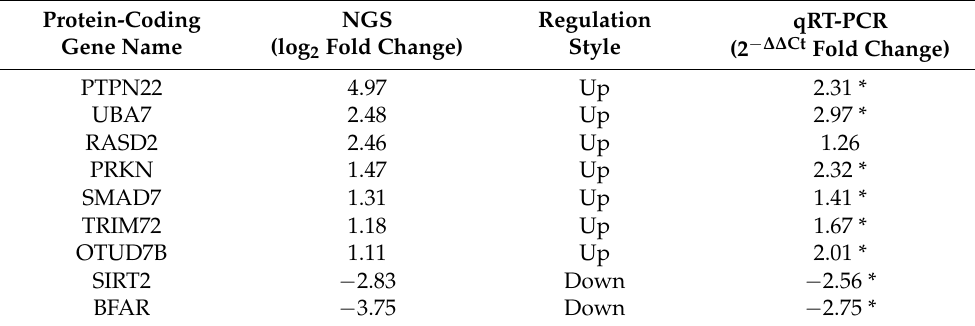
Table 1. qPCR was used to verify the ubiquitination and autophagy-related DEGs. Protein-Coding NGS Gene Name (log 2 Fold Change)